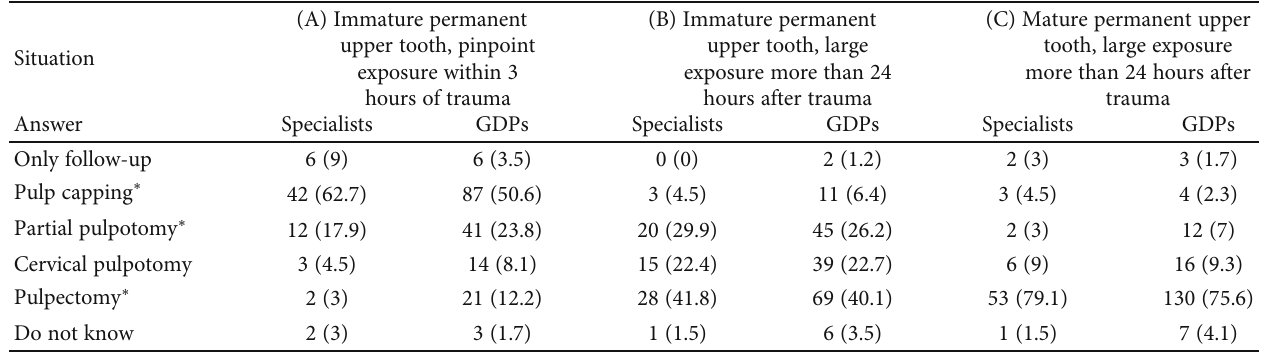
Table 3: Frequency distribution (%) of dentists ’ answers about emergency management of crown fracture.